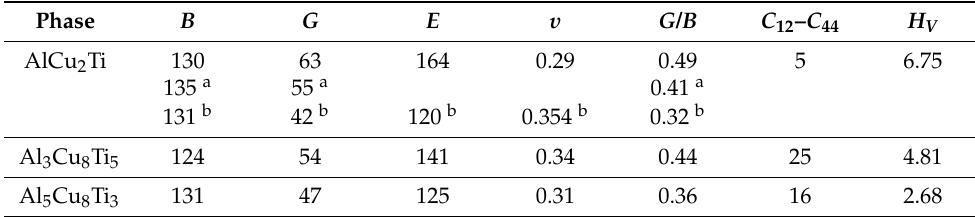
Table 11. The calculated bulk modulus B (GPa), shear modulus G (GPa), Young’s modulus E (GPa), Poisson’s ratio υ , Pugh’s ratio G / B , Cauchy pressure C 12 – C 44 , and Vickers hardness H V for the Al-Cu-Ti intermetallics.